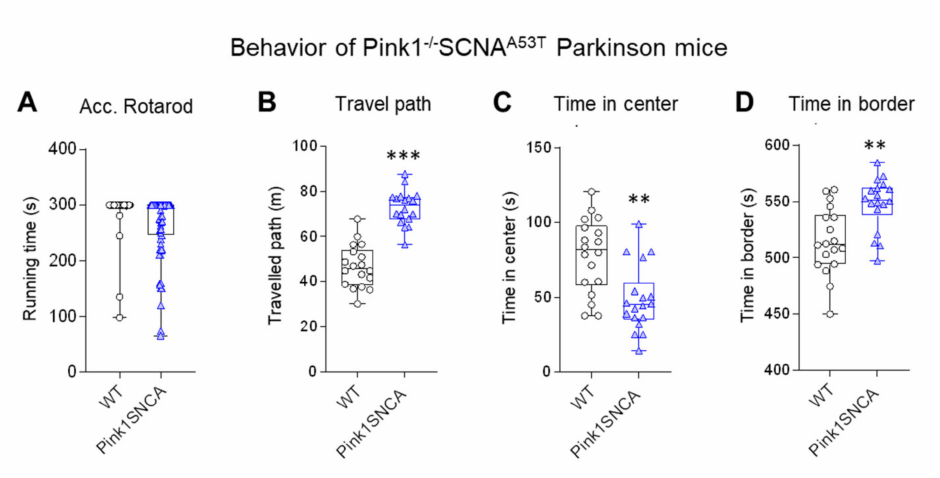
Figure 6. Behavior in genetic Parkinson Pink1 − / − SNCA A53T double mutant mice. ( A ) Running time on an accelerating Rotarod. ( B – D ) Travel paths and times spent in the center and border compartment in the open field test (OFT). Pink1 − / − SNCA A53T were hyperactively running along the walls. Mice were 12–15 months of age. Each scatter is a mouse; n = 18 per group. Data were compared with t -tests; asterisks indicate significant differences between